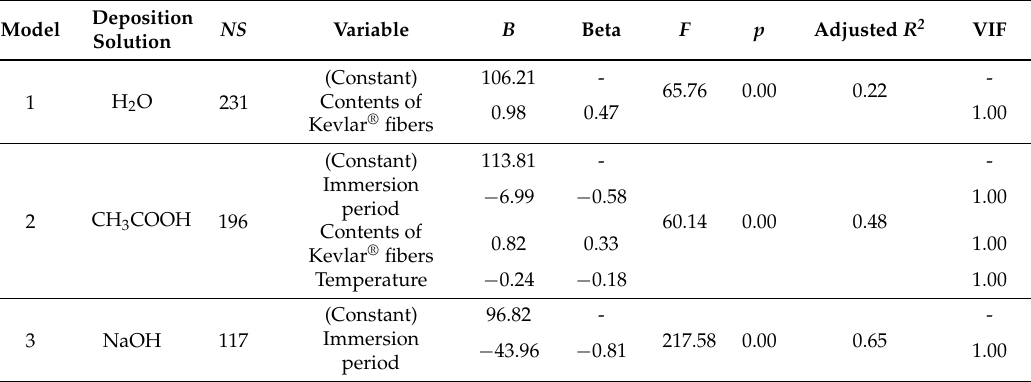
Figure 8. Tensile strength and weight along the CD of recycled Kevlar ® /PET/LPET nonwoven geotextiles of ( a ) H 2 O/23 ˝ C, ( b ) H 2 O/50 ˝ C, ( c ) CH 3 COOH/23 ˝ C, ( d ) CH 3 COOH/50 ˝ C, ( e ) NaOH/23 ˝ C, and ( f ) NaOH/50 ˝ C, as related to the implementation of thermal treatment. Table 5. Multiple regression analyses in the tensile strength of recycled Kevlar ® /PET/LPET nonwoven